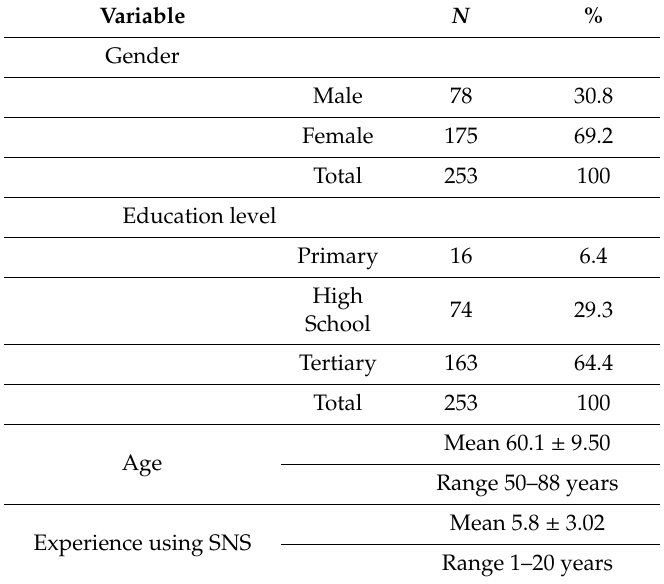
Table 2. Distribution of the variables of interest in older people. Concepci ó n, Chile, 2018.